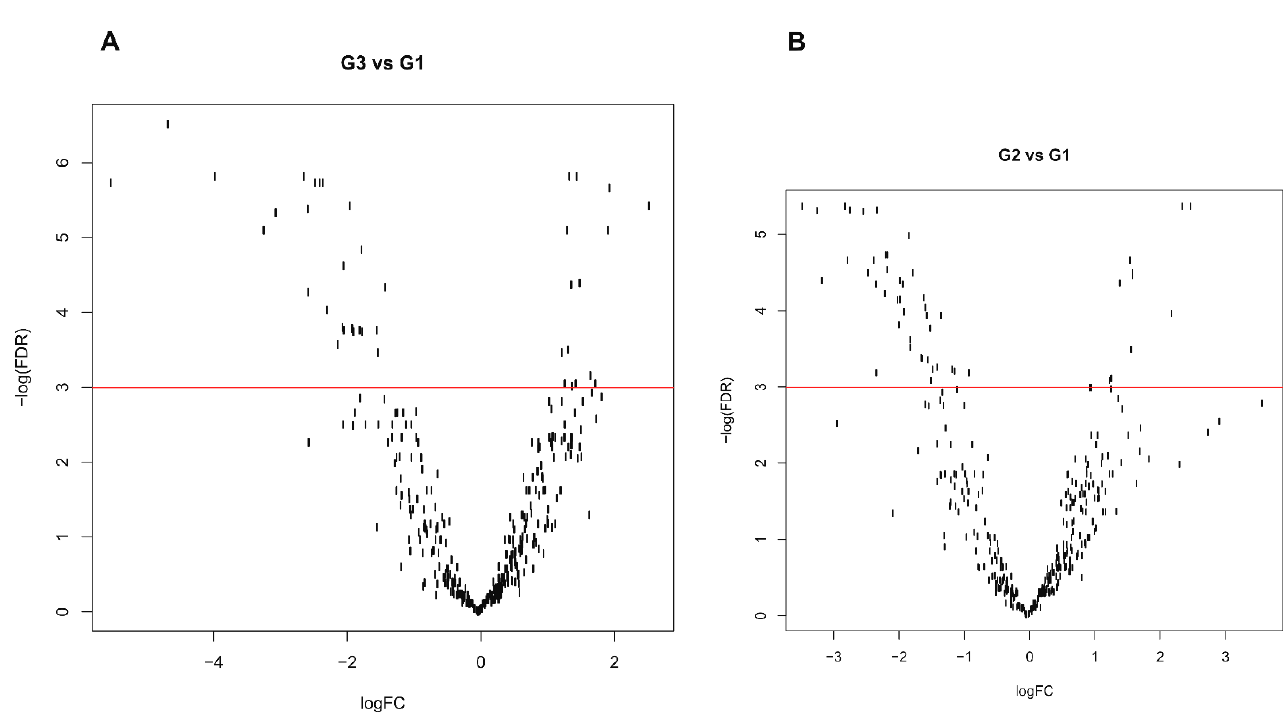
Figure 1. Volcano plots of differential expressed genes (DEG) between individual grades. ( A ) DEG between grade 3 and grade 1 samples. ( B ) DEG between grade 2 and grade 1 samples. X axis, logarithmic fold change value (logFC) and Y axis, negative logarithmic value of false discovery rate ( − logFDR). Each dot represents an individual miRNA transcript.